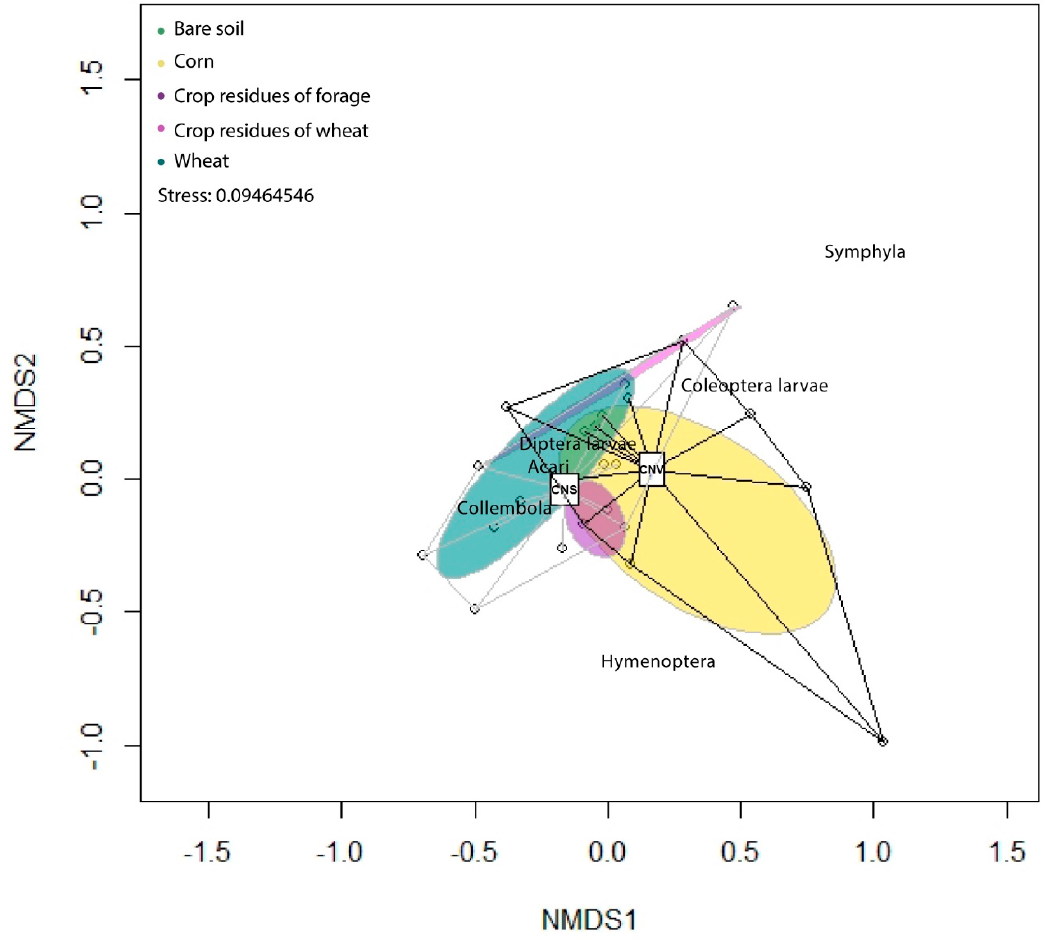
Figure 4. Bray-Curtis based NMDS plot of the arthropod community composition in Ruozzi farm. Points represent samples. “Spider” diagrams connect each point to the belonging management type: CNS: conservation, in grey, and CNV: conventional, in black. Ellipses represent crop variables. To avoid overlapping, only the six more abundant groups were labelled.